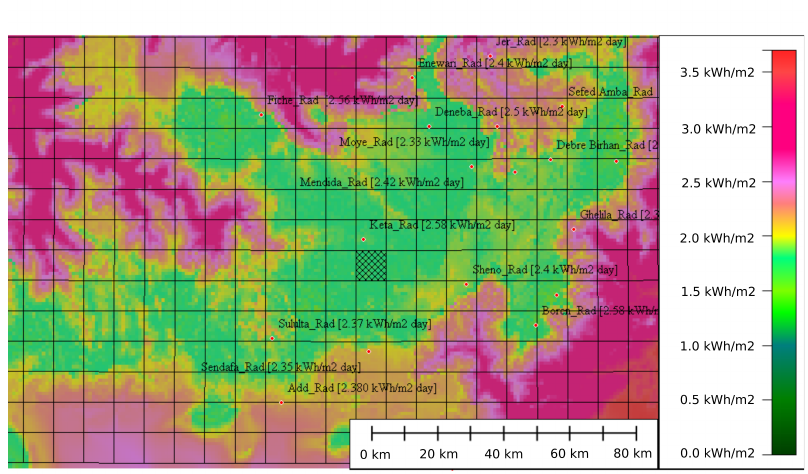
Figure 8. Comparison of coarse daily solar radiation data ( top ) and refined data of 1 km × 1 km ( bottom ), applying ANFIS estimation model.